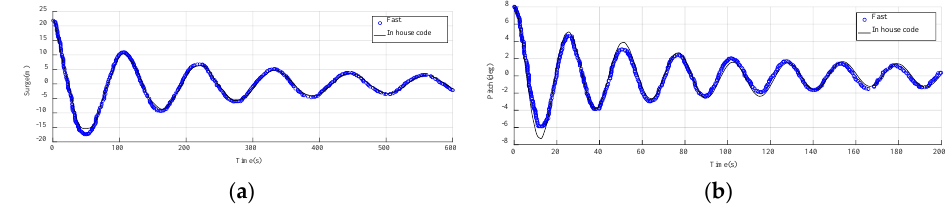
Figure 6. Comparison of the free-decay responses between Fatigue, Aerodynamics, Structures, and Turbulence (FAST) and the in-house developed code. ( a ) LCI; ( b ) LCIII.